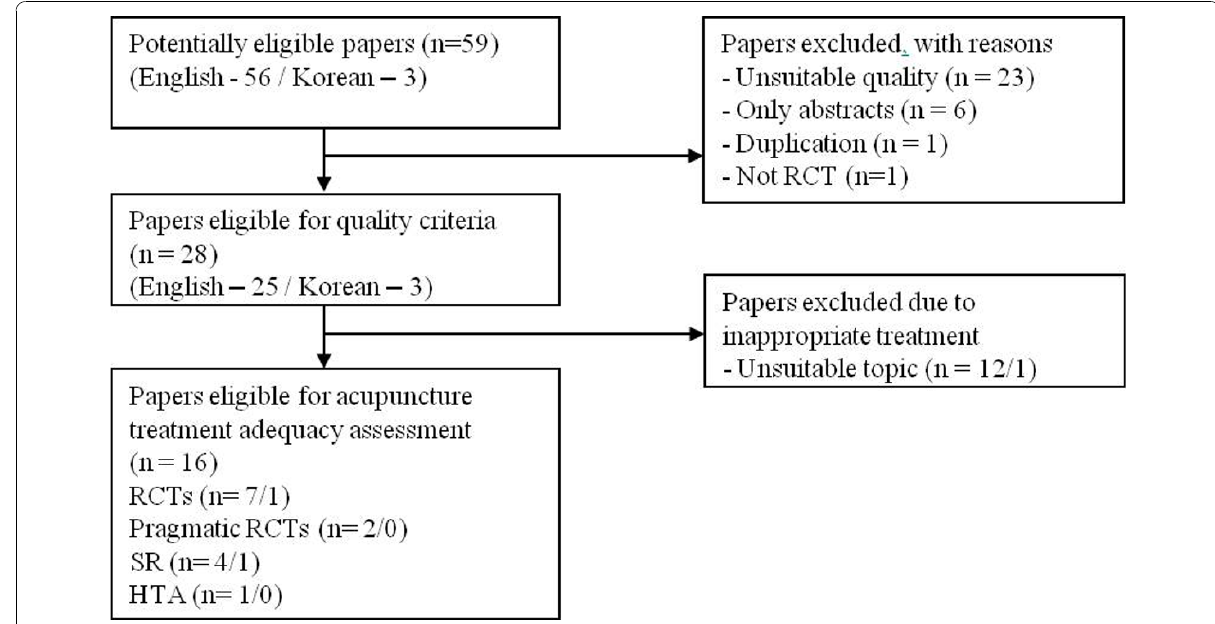
Figure 2 Systematic review flow diagram